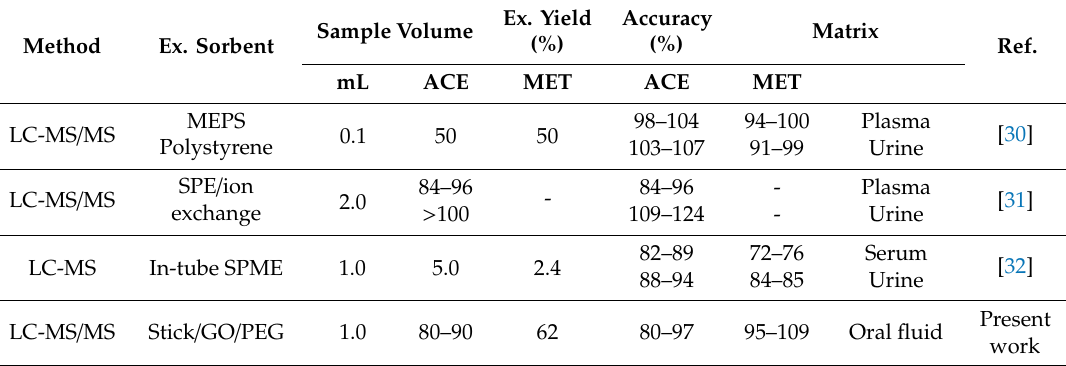
Table 3. Comparison of the proposed method with other extraction methods for the analysis of acebutolol and metoprolol. Microextraction by packed sorbents, MEPS; solid phase extraction, SPE; solid phase microextraction,